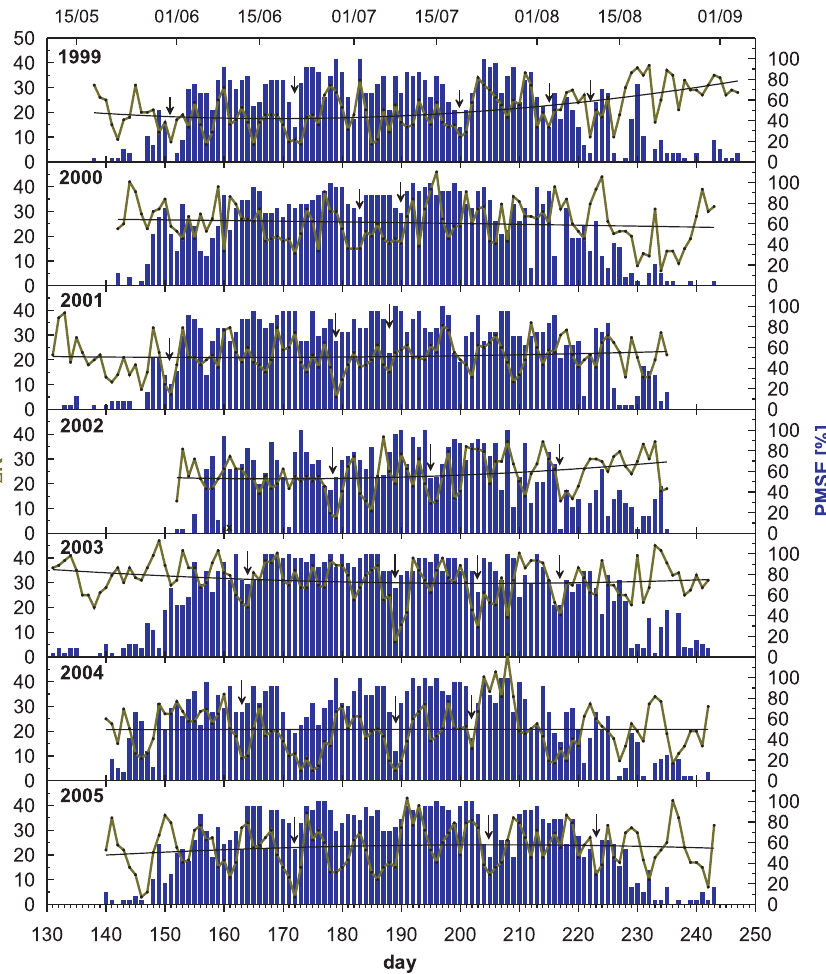
Fig. 3. Seasonal variation of PMSE occurrence rates (blue bars) and of geomagnetic activity 6K at Tromsø (green curves) for different years (1999–2005). The black curves are polynomial fits to demonstrate the mean seasonal variation of 6K , arrows show pronounced minima in PMSE and 6K